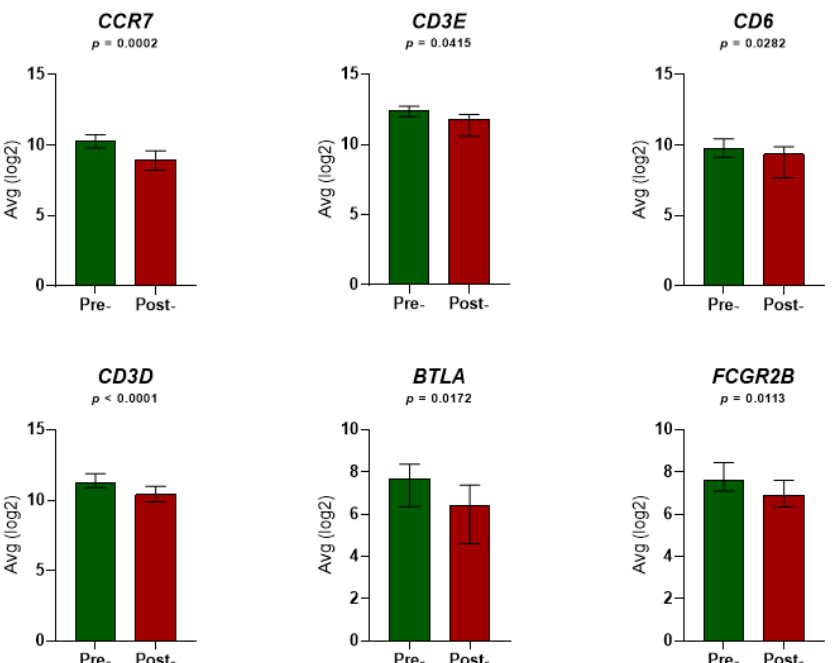
Figure 1. Expression levels of the six immune-related genes in the peripheral blood of 23 localized prostate cancer (LPCa) patients before and after radiation therapy (RT). Each graph corresponds to expression level alterations of each single gene pre-RT and post-RT. Each column illustrates the average mRNA levels of each gene normalized by RPM and log2-transformed. Non-parametric Wilcoxon’s (paired) test was performed to indicate whether the expression levels pre-RT and post-RT differed significantly among patients. The error bars denote the median values with interquartile range. P values below 0.05 indicate statistical significance. Avg: average.